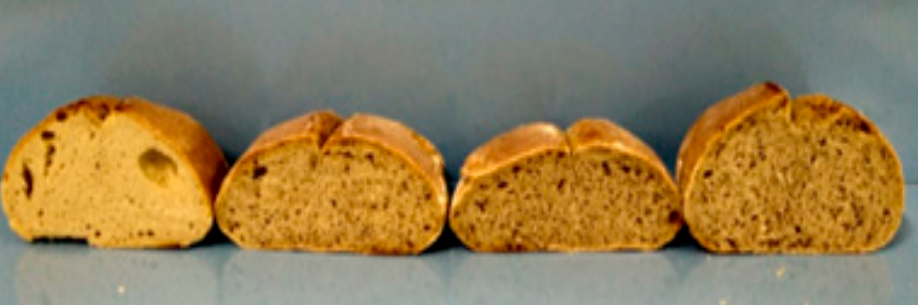
Figure 4. Bread with the addition of Norik wholemeal flour (from left side: control sample, sample with 3% addition, sample with 6% addition, and sample with 9% addition).